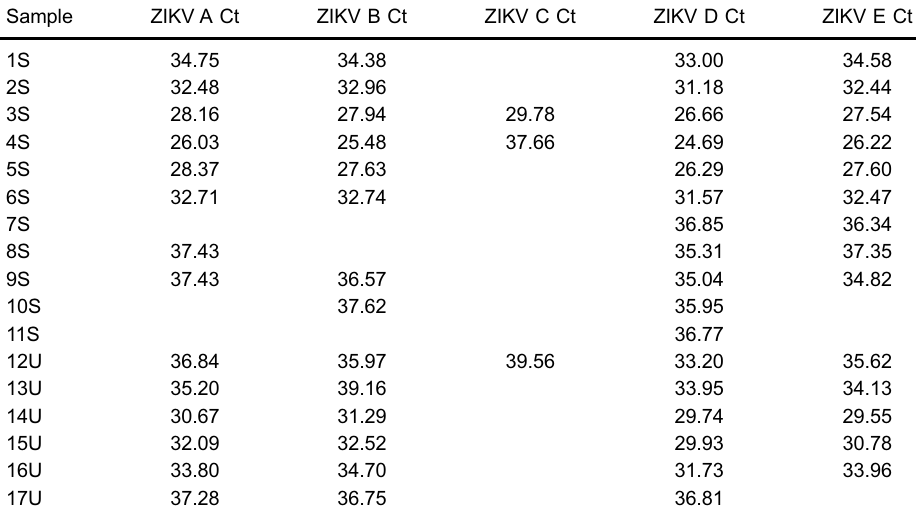
Table 3. Cycle threshold of primer/probe protocols used to test the presence of Zika virus (ZIKV) in serum (S) and urine (U) samples from infected patients. Sample